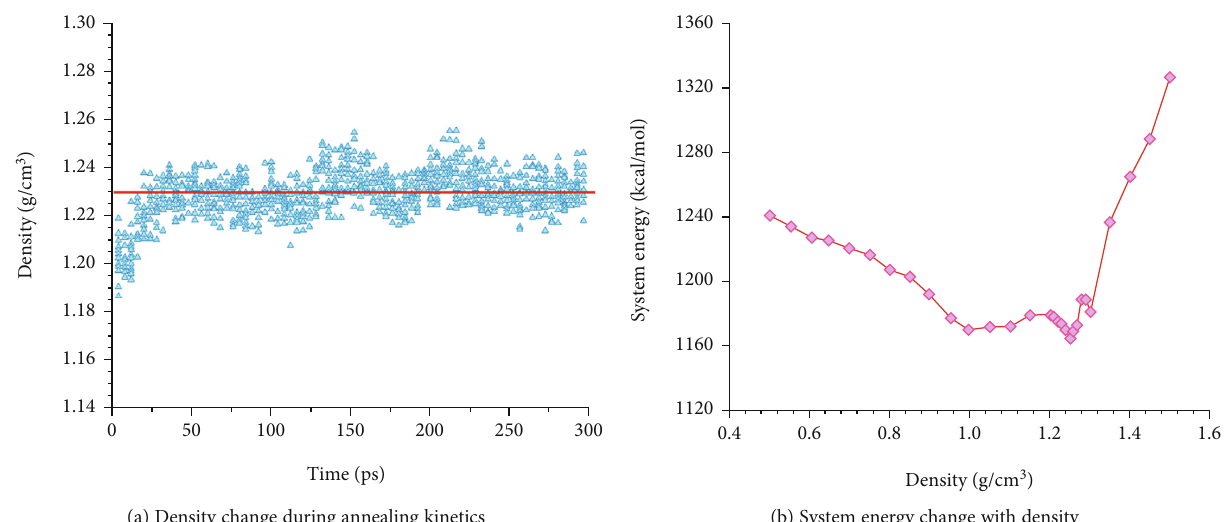
Figure 3: Variation of energy with density in unit cell system of